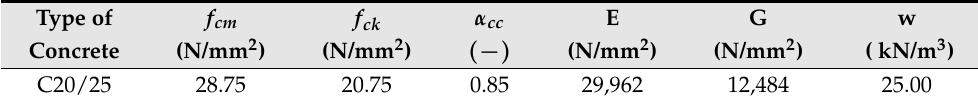
Table 2. Mechanical characteristics of concrete.